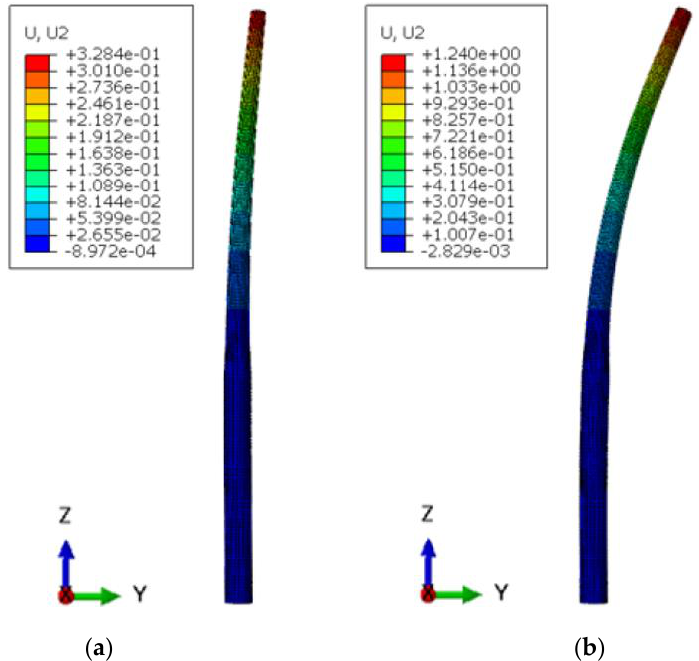
Figure 13. Lateral displacement: ( a ) Normal conditions, ( b ) Extreme sea state.